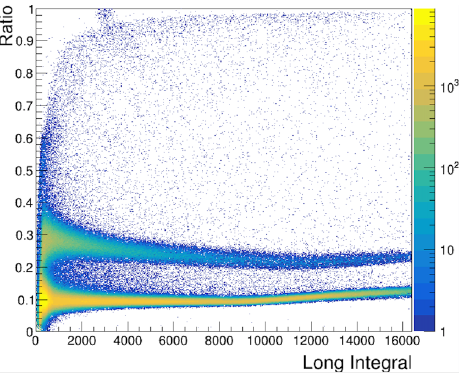
Fig. 3. Plotting the ratio from Eq. (2) versus the long integral of a signal, we can clearly see a delineation between the two radiation types. We can label each signal a neutron or a gamma based on which side of Ratio=0.2 they are